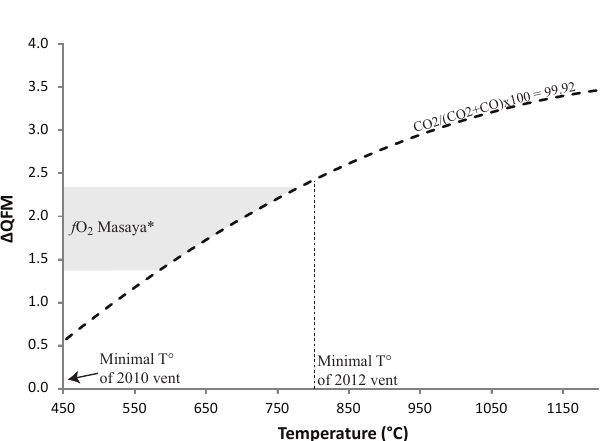
Figure 6 Moussallam et al.,